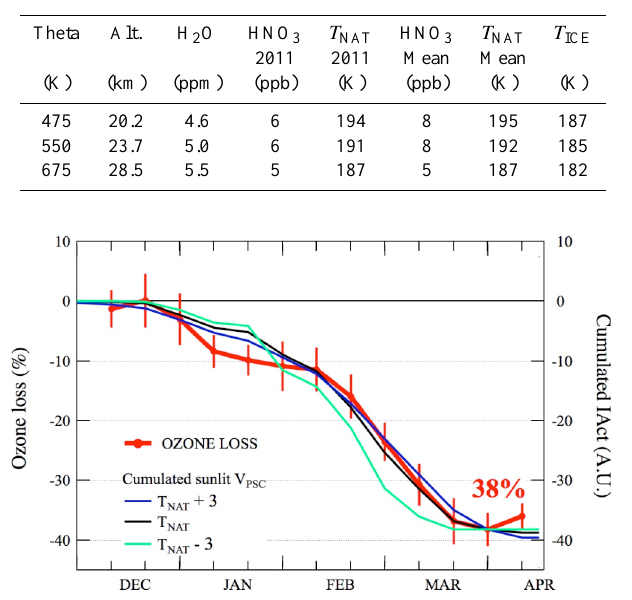
Fig. 6. O 3 loss and vortex sunlit-weighted PSC cumulated volume calculated for T NAT − 3K (green), T NAT (black) and T NAT + 3K Figure 6. O Loss and vortex sunlit weighted PSC cumulated volume calculated for T 3 (blue) normalised on 30 March. (green), T (black) and T +3K (blue) normalised on March 30. NAT NAT